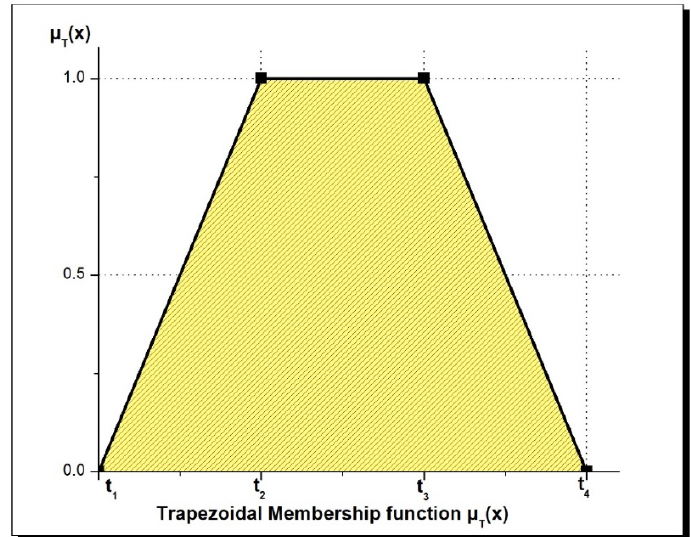
Figure 1. Trapezoidal Membership function µ T ( x ).